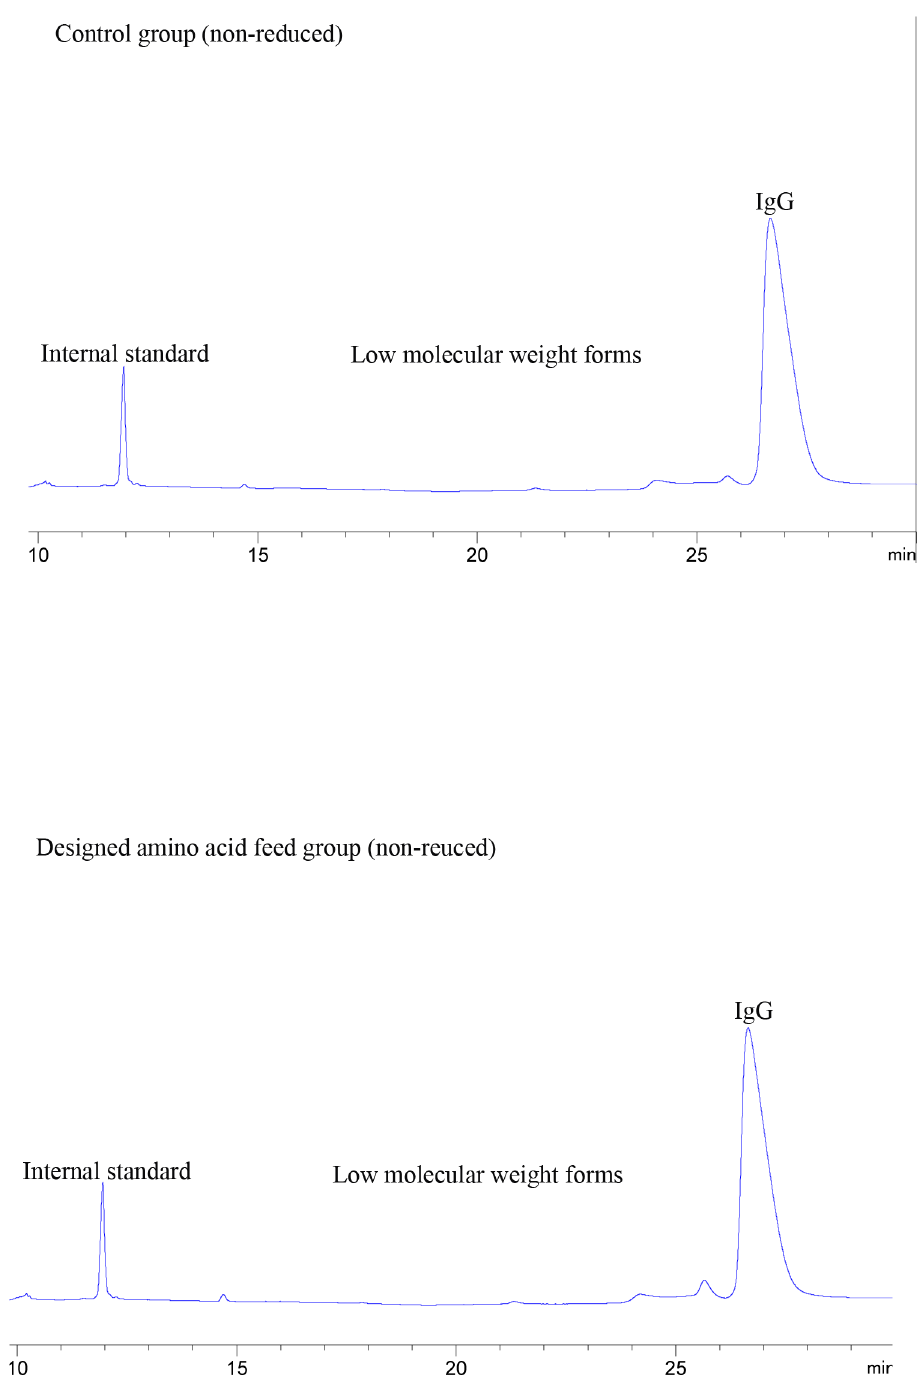
Fig 6. Electropherograms of non-reduced bevacizumab in control and designed amino acid feed groups.